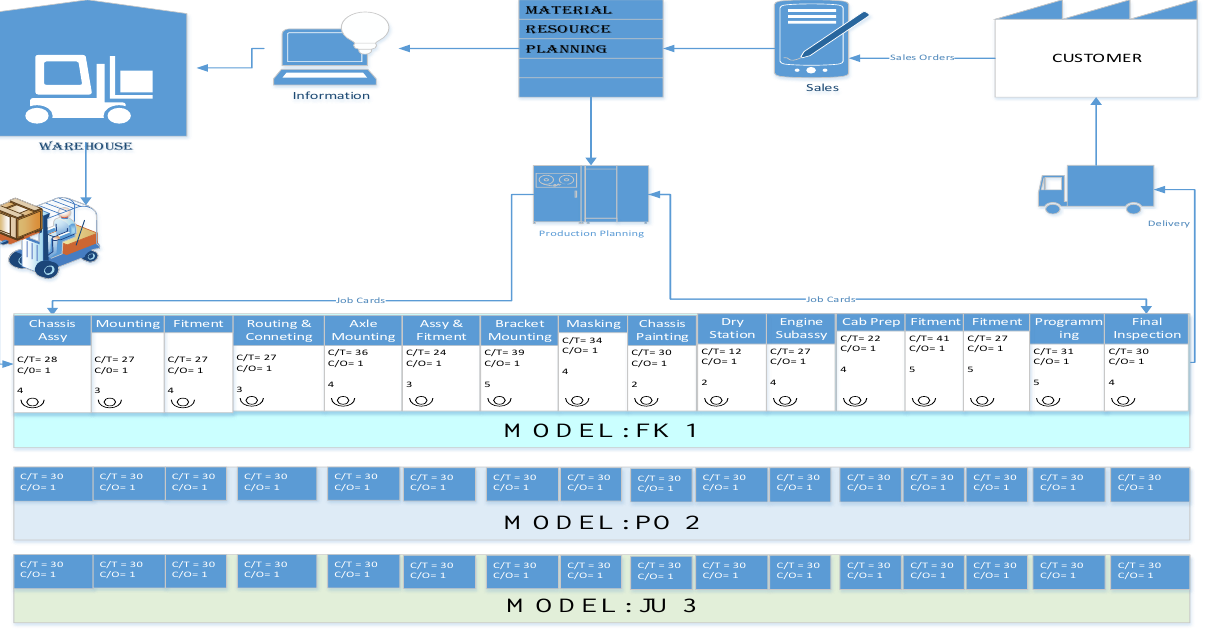
Figure 1. VSM modelling of the current state of the truck manufacturing industry (FK1, PO2 and JU3 are named after the workstations; C/T is cycle times and C/O operations times).